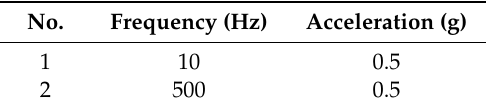
Table 1. Profile of harmonic excitation.